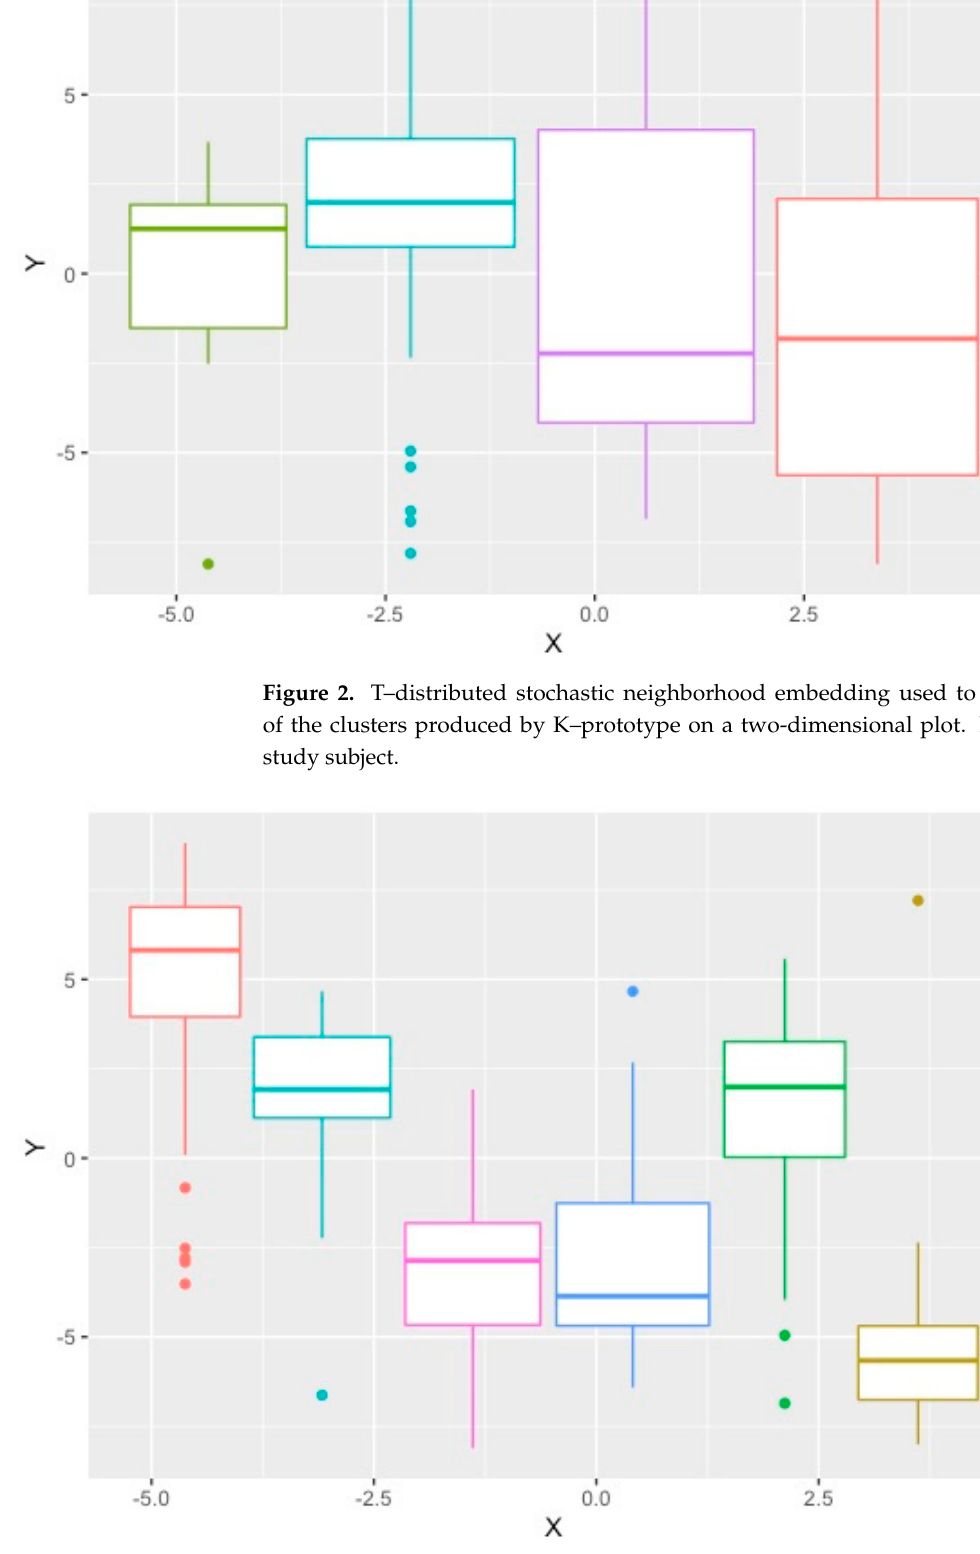
Figure 3. T–distributed stochastic neighborhood embedding used to show the local structures of the clusters produced by PAM on a two–dimensional plot. Each point represents one study subject.